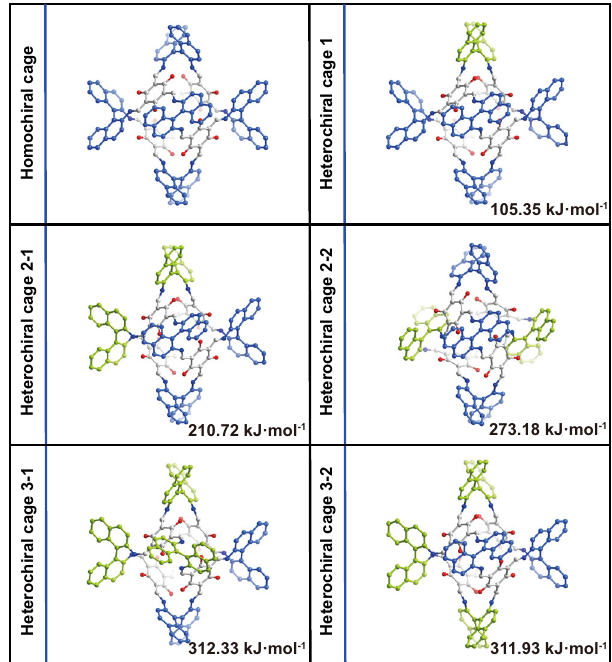
Fig. 2 The optimized cage structures based on DFT calculations. The possible cage isomers (enantiomers not included) and their corresponding enthalpies ( Δ H ) kJ·mol − 1 . blue binaphthyl: (S)-enantiomer, yellow binaphthyl: